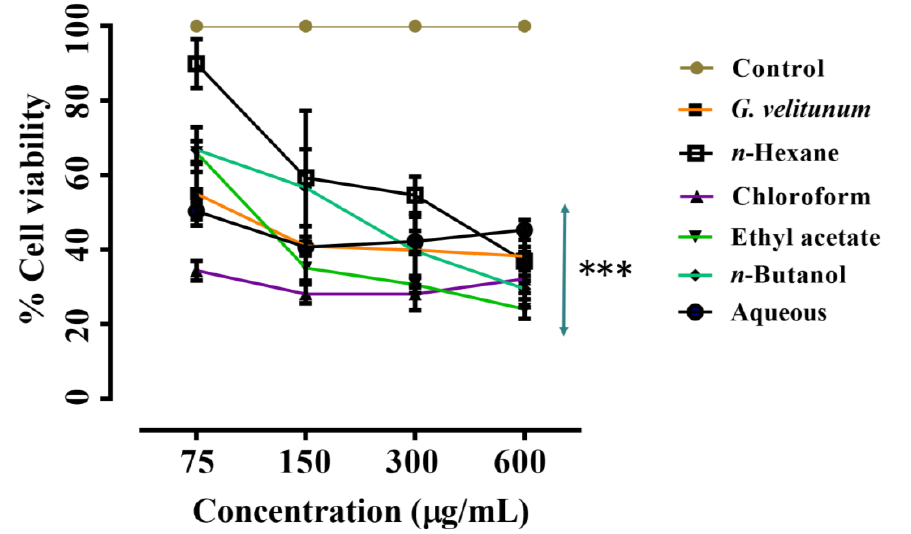
Figure 4. Presentation of growth inhibitory effects of G. velutinum extract and its fractions on PC-3 cells. The results are expressed as a percentage of the negative control. Data are means ± SD of three independent experiments. *** represent p ≤ 0.001.